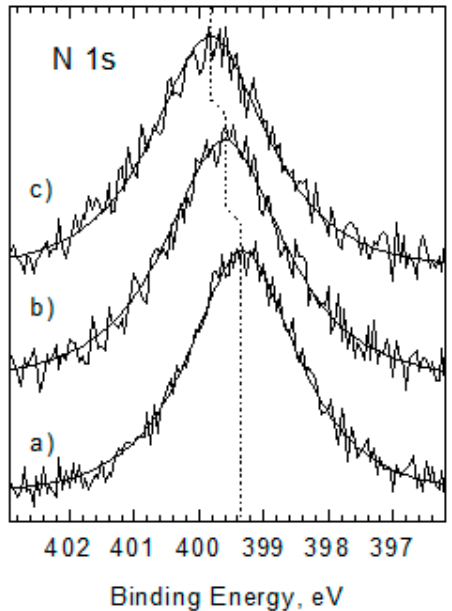
Figure 2. N 1s core level spectra for DNA surface (as reference) ( a ), Pd/DNA (C1) prepared at RT ( b ), and Pd/DNA (C2) prepared at 80 °C ( c ).